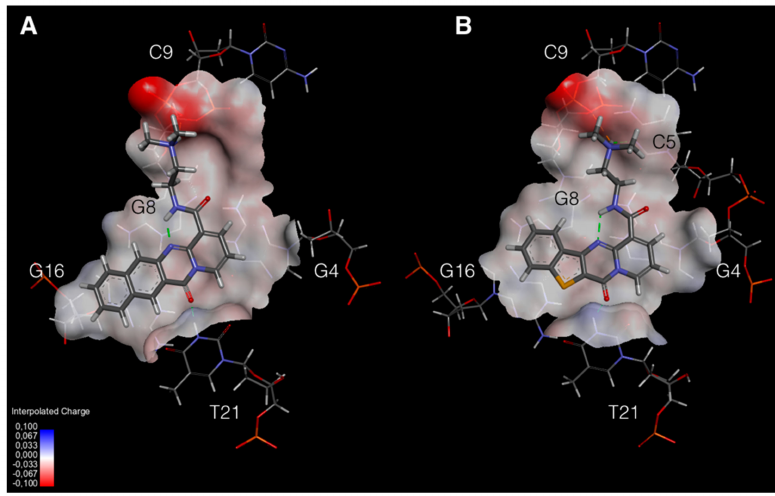
Figure 8. Molecular models of the optimized complexes of 1 ( A ) and 2 ( B ) with c-kit21T12T21 at the 3 (cid:48) -end G-tetrad binding sites. Ligands are rendered with sticks while bases are with lines, both colored by atoms. Solvent accessible surfaces (SAS) are coded following the lower left scale in the figure. Hydrogen bonds are represented by dashed green